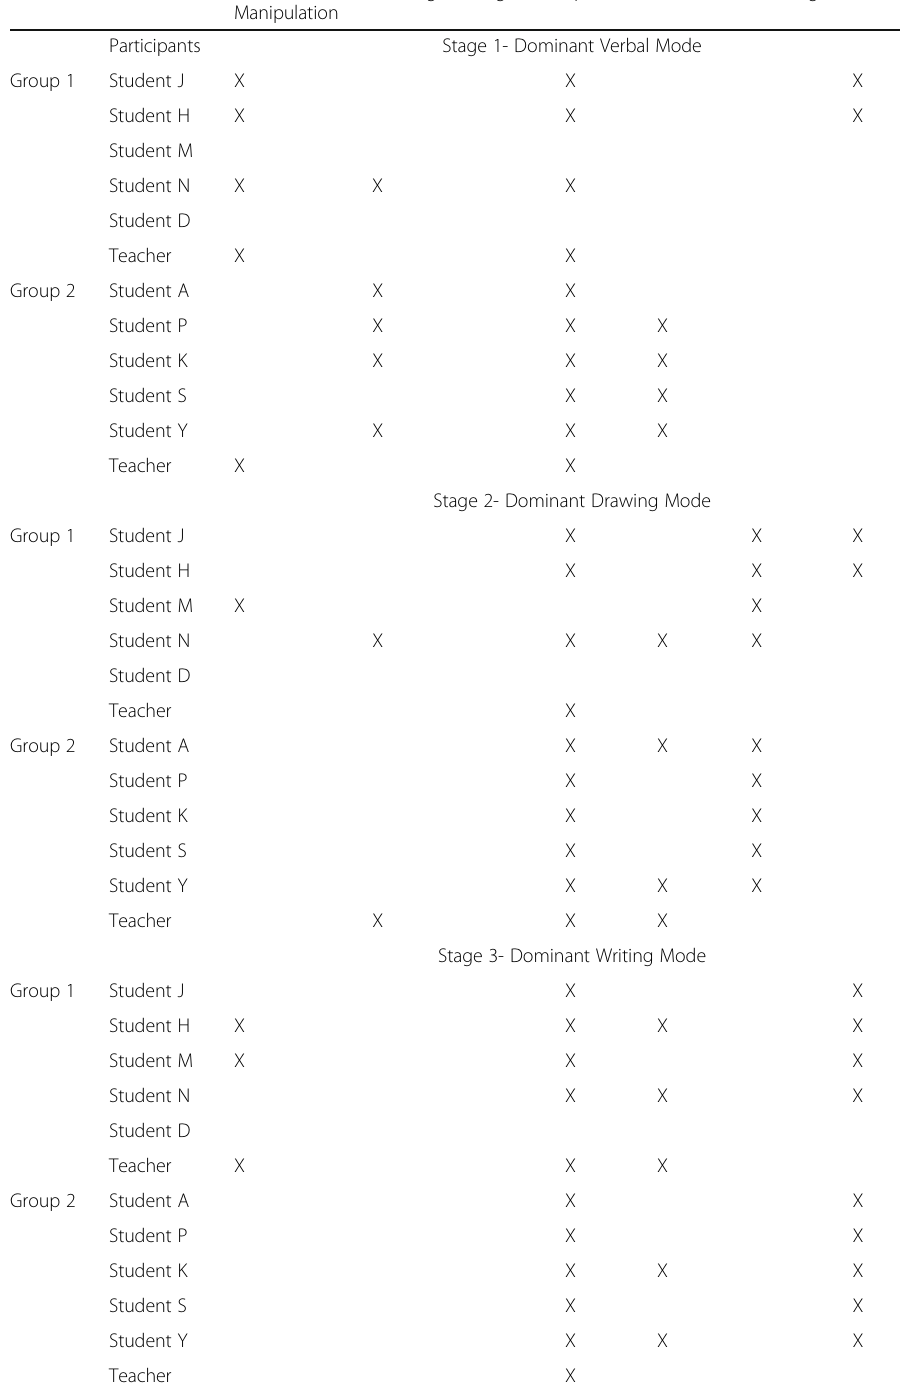
Table 3 Modes Used by Participant ’ s during Inquiry Lesson 1 Model